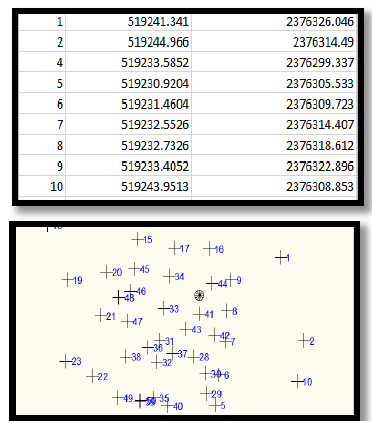
Figure 5: The 3D point cloud model of the Building.